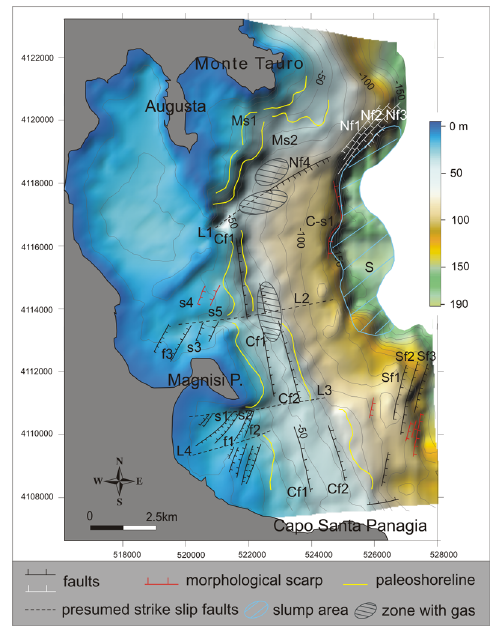
Figure 9. Morphobathymetric maps of the seafloor with geomor- phologic and structural elements: faults, scarps and paleoshorelines. Faults are represented in both black and white for a better graphic clar- ity. Dashed lines indicate the morphological lineaments considered strike-slip faults on the basis of the morphological